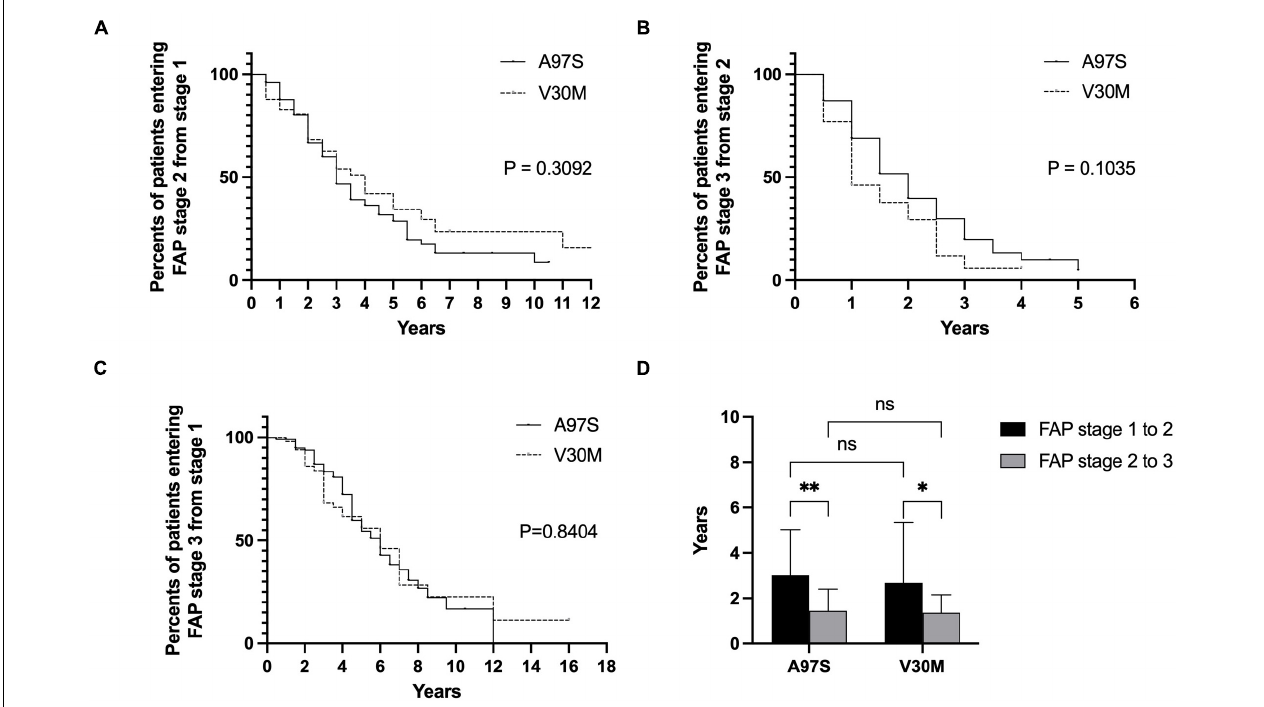
FIGURE 4 | The disease progression in ATTRv between A97S and V30M according to the interval of FAP stage from 1 to 2, 2 to 3, and 1 to 3. There was no difference in the Kaplan–Meier survival curve between A97S and V30M according to the analysis of the interval entering stage 2 from stage 1 (A) , in the interval entering stage 3 from stage 2 (B) , and in the interval entering stage 3 from stage 1 (C) . (D) The interval of FAP stage 1–2 was longer than the interval of FAP stage 2–3 in both A97S and V30M ATTRv cohorts (A97S: 3.0 ± 2.0 years vs. 1.4 ± 1.0 years, P < 0.0001; V30M: 2.7 ± 2.7 years vs. 1.4 ± 0.8 years, P = 0.04). * P < 0.05; ** P < 0.01; ns, no significant differences. TABLE 4 | Clinical factors affecting the progression in ATTRv. ATTRA97S in Taiwan ATTRV30M in